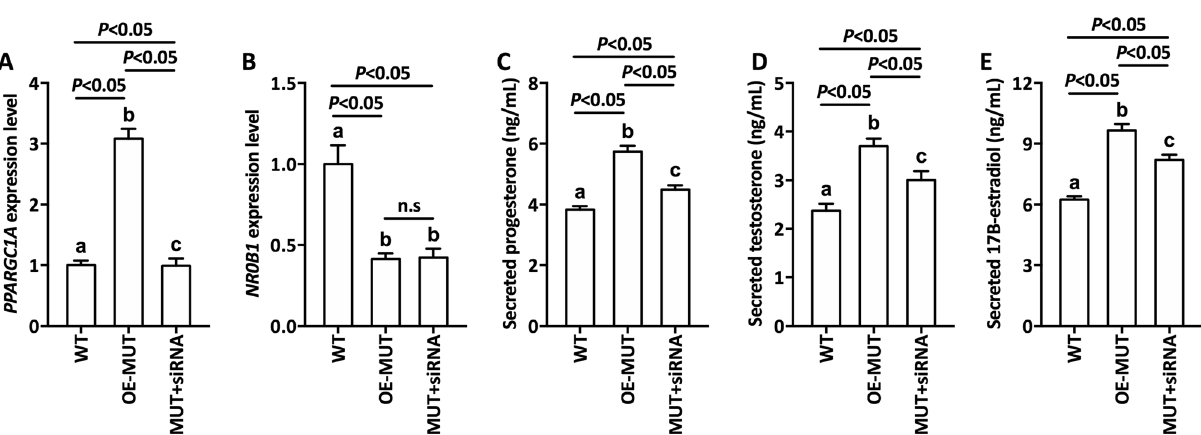
Figure 6. The levels of typical transcriptional factor and hormone of transfected and non-transfected cells. ( A ) StAR, ( B ) SF-1, ( C ) CYP11A1, ( D ) FSH, and ( E ) LH. StAR: Steroidogenic acute regulatory protein, SF-1: Steroidogenic factor 1, CYP11A1: Cytochrome P450 steroidogenic enzyme CYP11A1, FSH: Follicle stimulating hormone, LH: Luteinizing hormone. Error bars represent the standard deviation from triplicate samples. Different lowercase letters represent the significance of differences at P < 0.05.